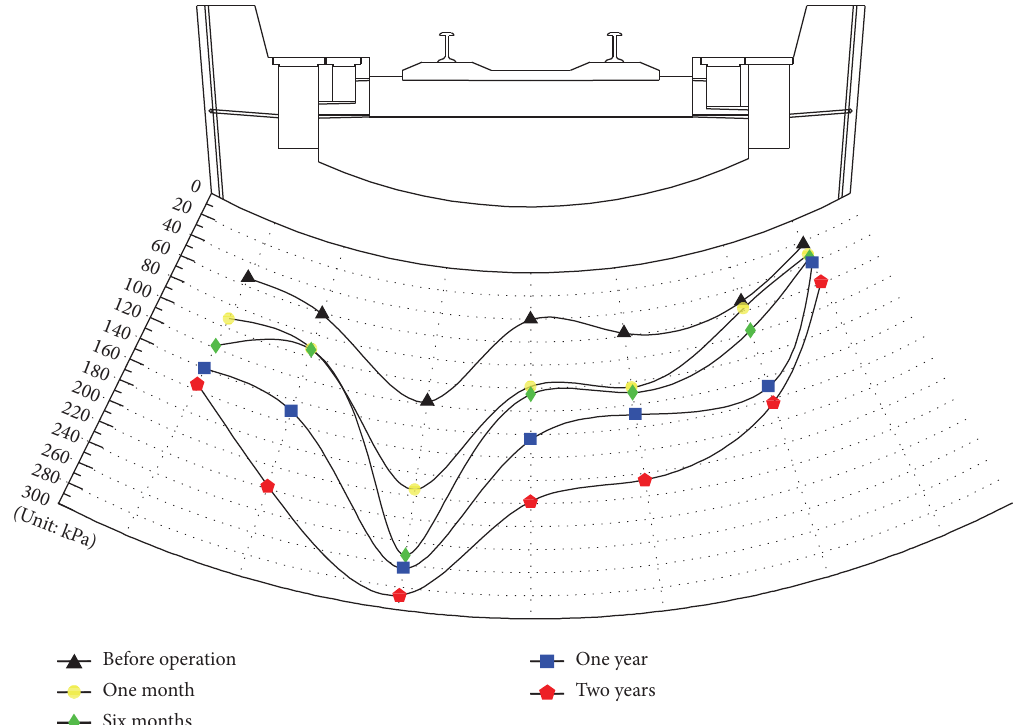
Figure 8: Water pressure change diagram of surrounding rock at the